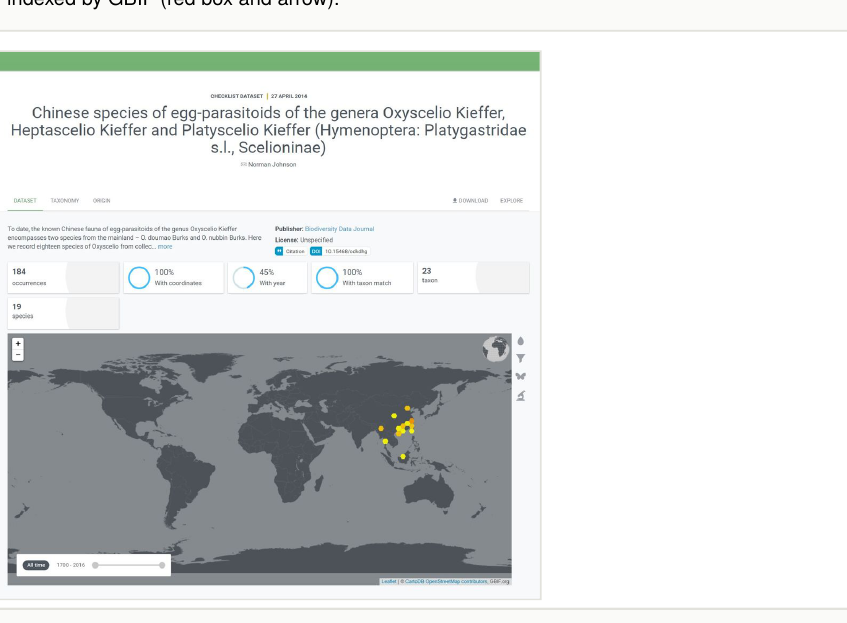
The occurrence data from articles published in the Biodiversity Data Journal (in this case from the paper of Johnson 2013) are automatically indexed via Darwin Core Archive in the GBIF Integrated Publishing